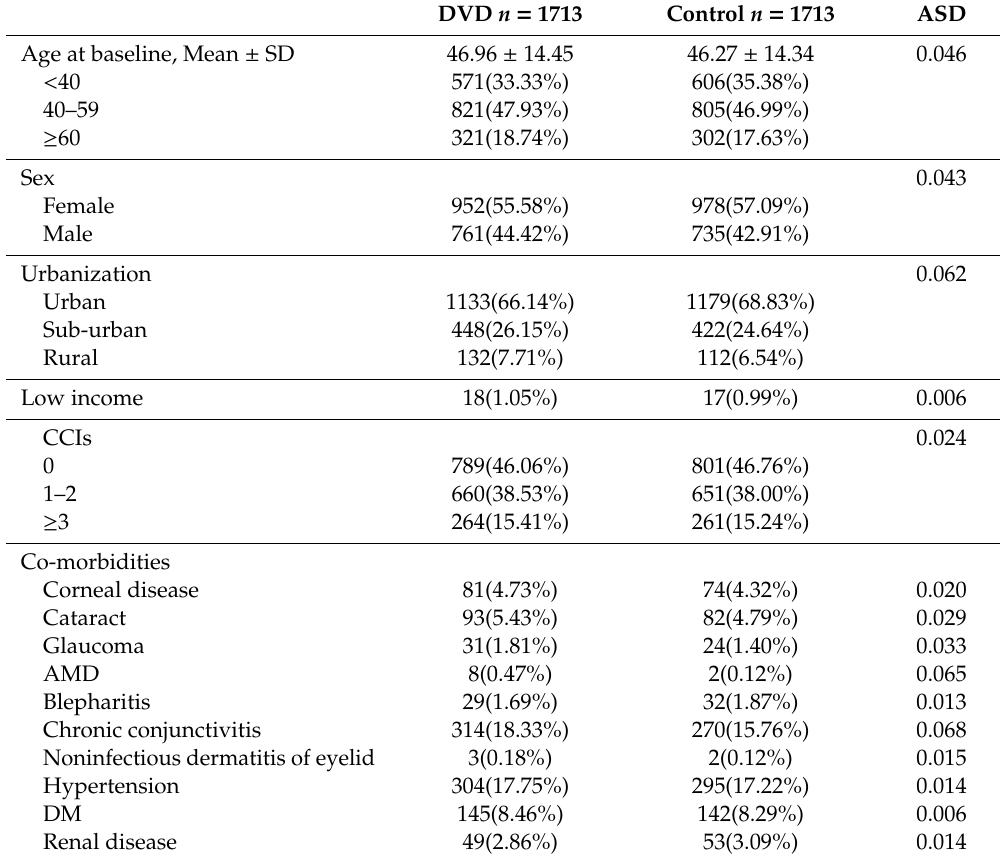
Table 1. Basic characteristic at baseline in the study group and the matched control